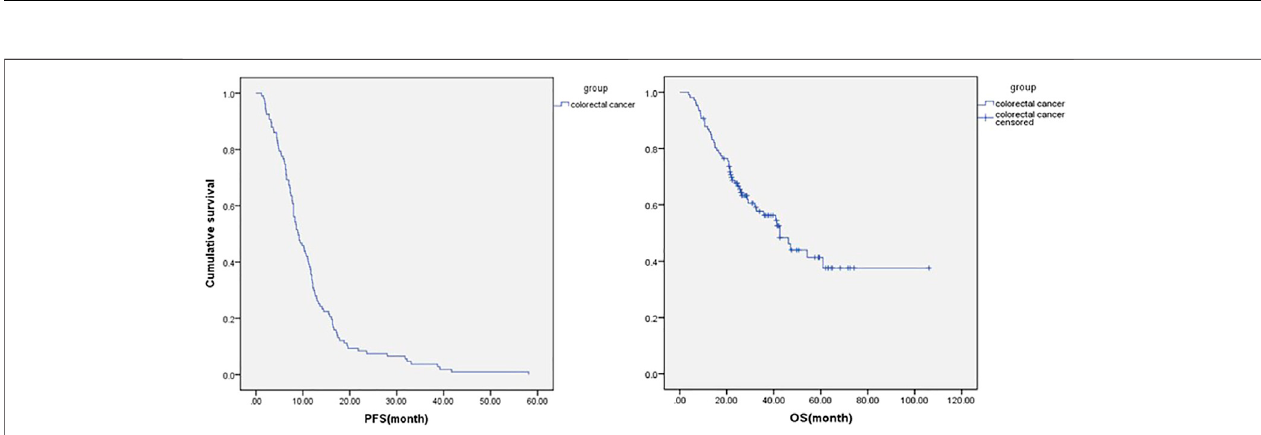
FIGURE 3 | Progression-free survival and overall survival in all metastatic colorectal cancer patients who had progression information ( n (cid:1) 107).